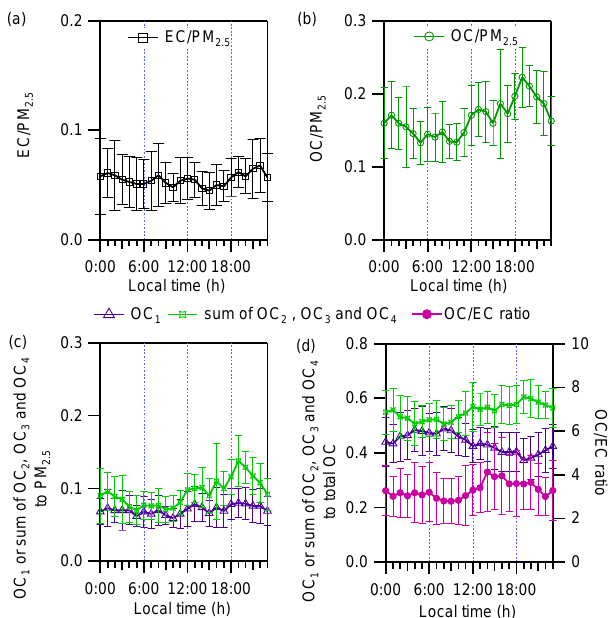
Figure 7. Mean back trajectories of the six types of air masses ar- riving at the sampling